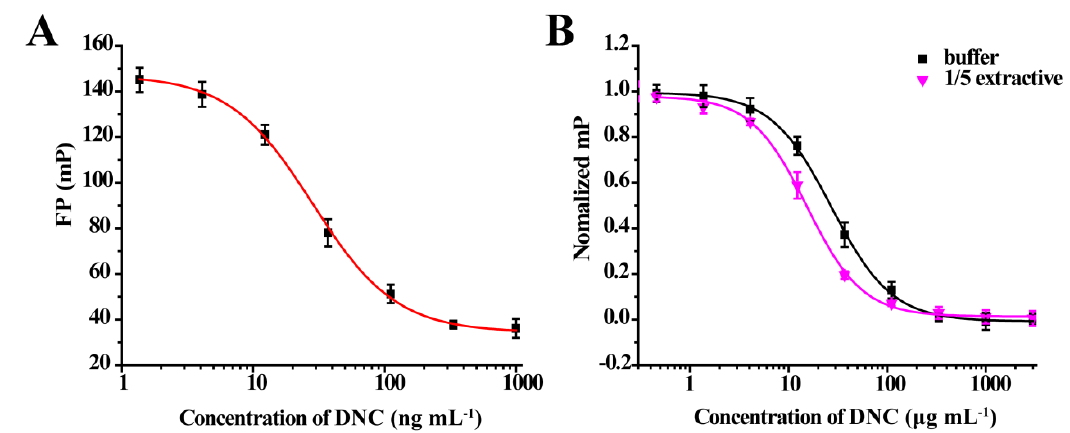
Figure 5. ( A ) Standard curves for NIC using the FPIA in assay buffer under optimized conditions. ( B ) Comparison of FPIA curves obtained from standards prepared in assay buffer, and 5-fold diluted chicken extracts. Table 2. IC 50 values and Cross-reactivity of DNC and 15 structurally related analogs for the FPIA. Analogues